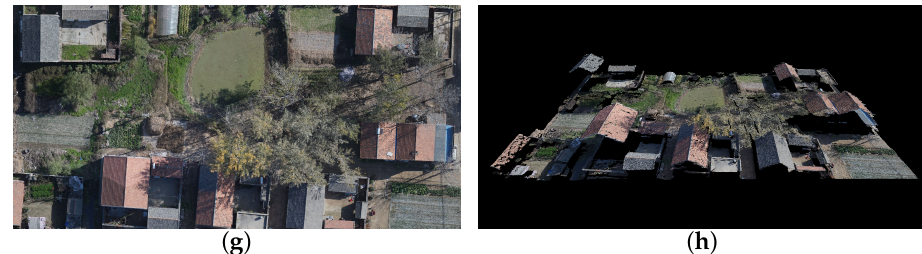
Figure 12. The beginning, two intermediate, and final results of the generation process. The left column ( a , c , e , g ) is the top view, and the right ( b , d , f , h ) is the corresponding oblique view.